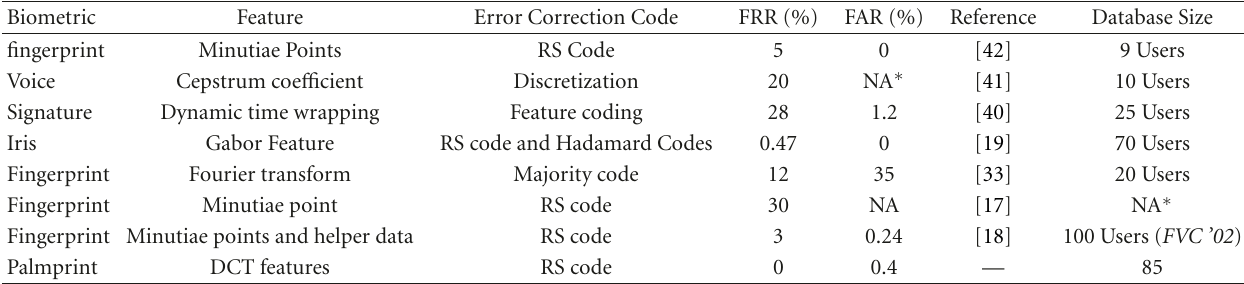
Table 2: Summary of related prior